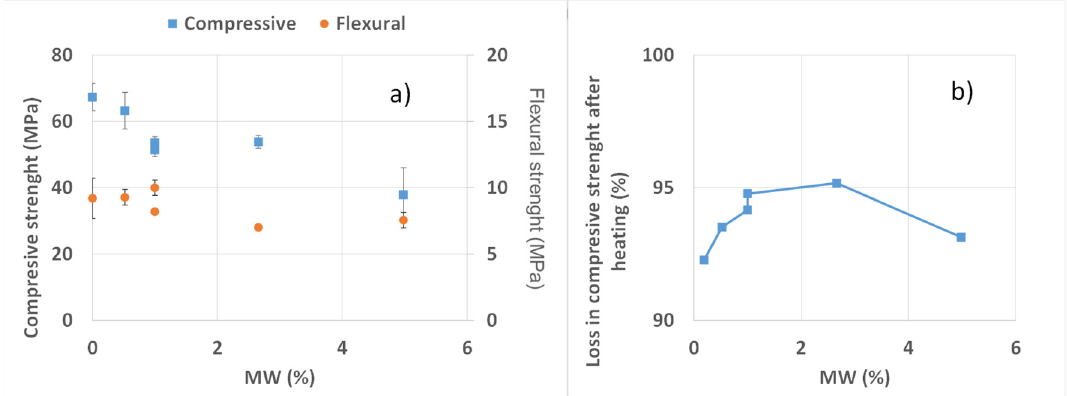
Figure 2. ( a ) Compressive and flexural strength for the samples with different MW (%). The standard deviations are given as error bars. ( b ) Loss in compressive strength after the heating tests with respect to the initial values.